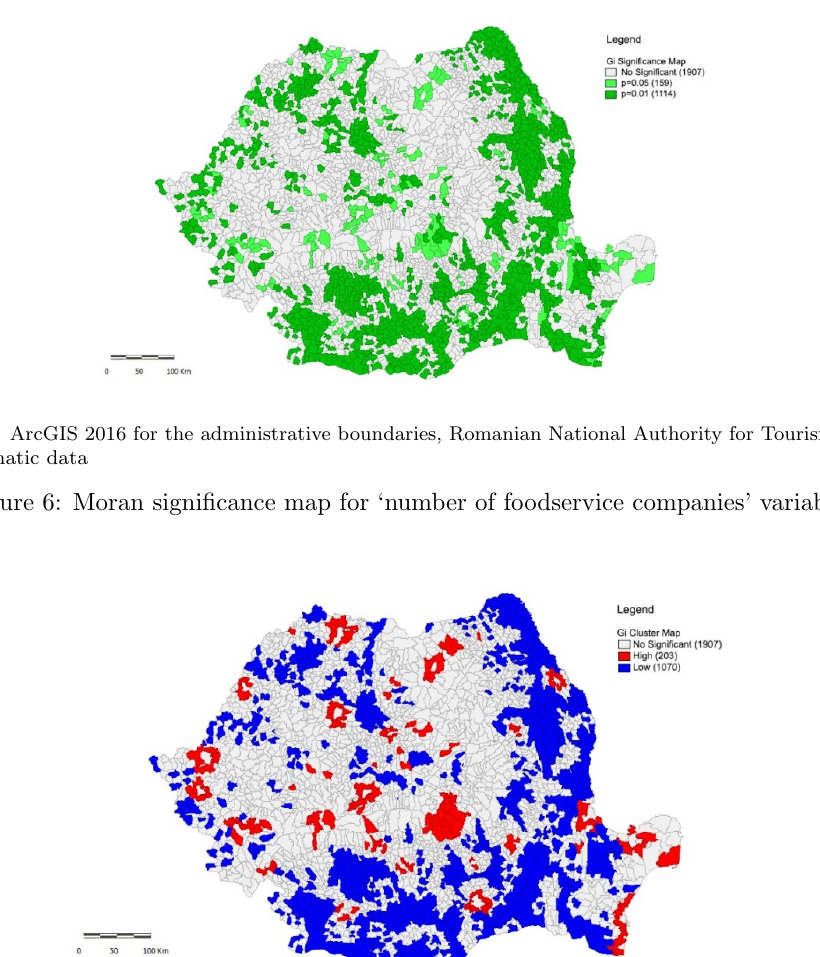
Figure 7: Categories of significant spatial associations of LAUs in terms of number of foodservice